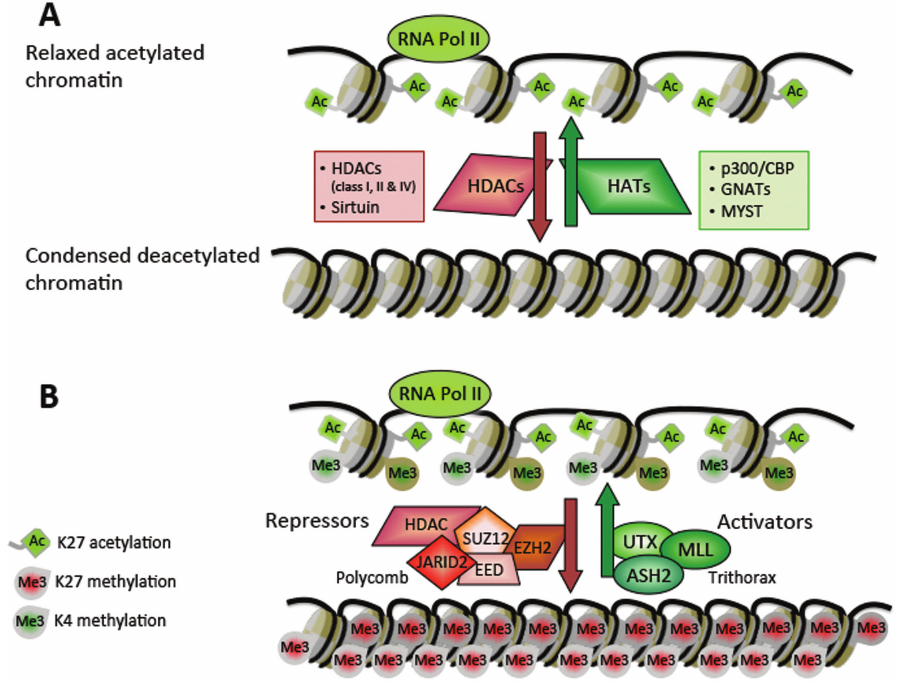
Figure 2: Schematic model for the role of methyltransferases/demethylases in transcriptional control of genes. (A) Histone acetylation affects chromatin structure. The dynamic state of histone acetylation/deacetylation is dictated by reciprocal reac- tions catalyzed by HAT (e.g., p300/CBP) and HDAC (e.g., HDAC1) enzymes. Acetylation of histones promotes chromatin decondensation, enhances accessibility of chromatin, and allows DNA-binding proteins to interact with exposed sites to activate transcription of subset of genes. (B) The involvement of demethylases/methyltransferases in transcriptional control of developmental genes. Histone